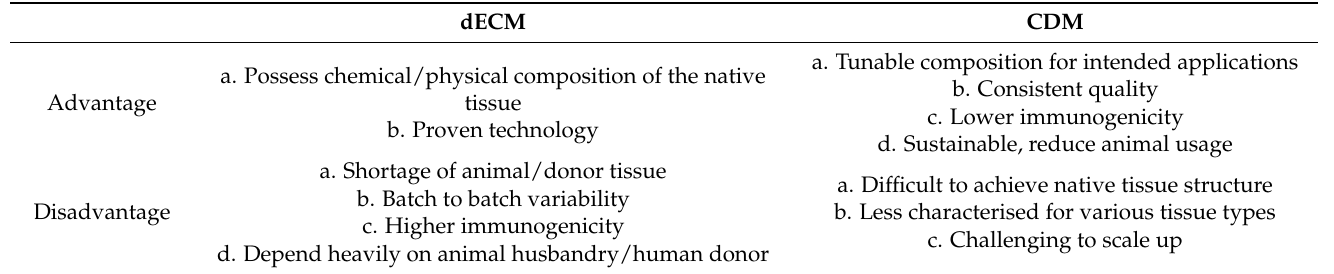
Table 1. Decellularised extracellular matrices (dECM) vs Cell-derived Matrices (CDM).